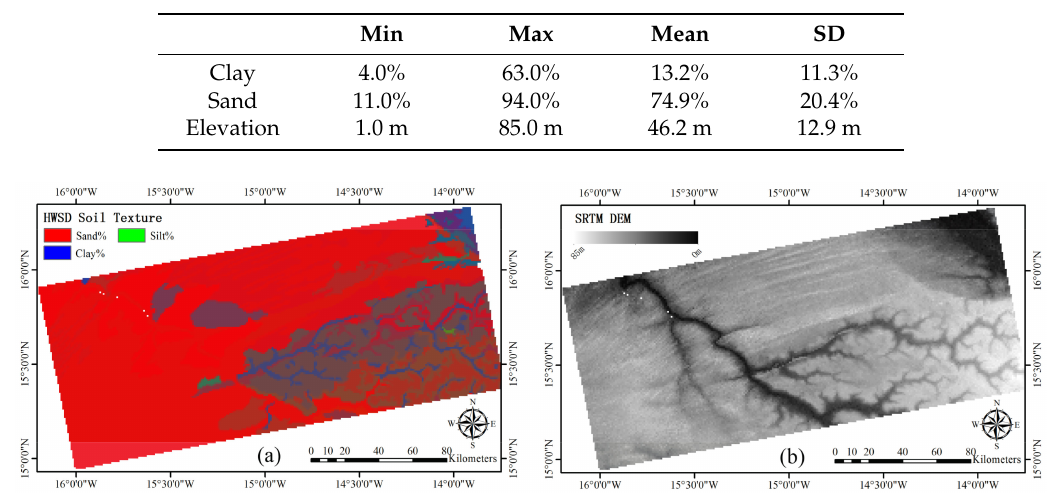
Figure 2. Soil texture and DEM information of the Dahra study site: ( a ) the false-color map of soil texture taking the sandy portion as red, the silty portion as green and the clayey portion as blue; ( b ) Shuttle Radar Topography Mission (SRTM) DEM